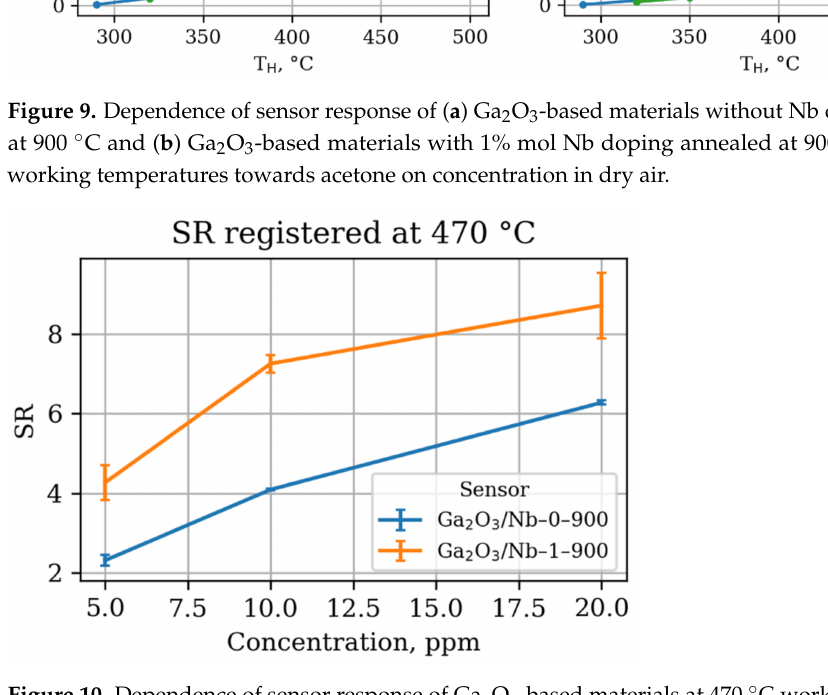
Figure 10. Dependence of sensor response of Ga 2 O 3 -based materials at 470 ◦ C working temperature towards acetone on its concentration in dry air.